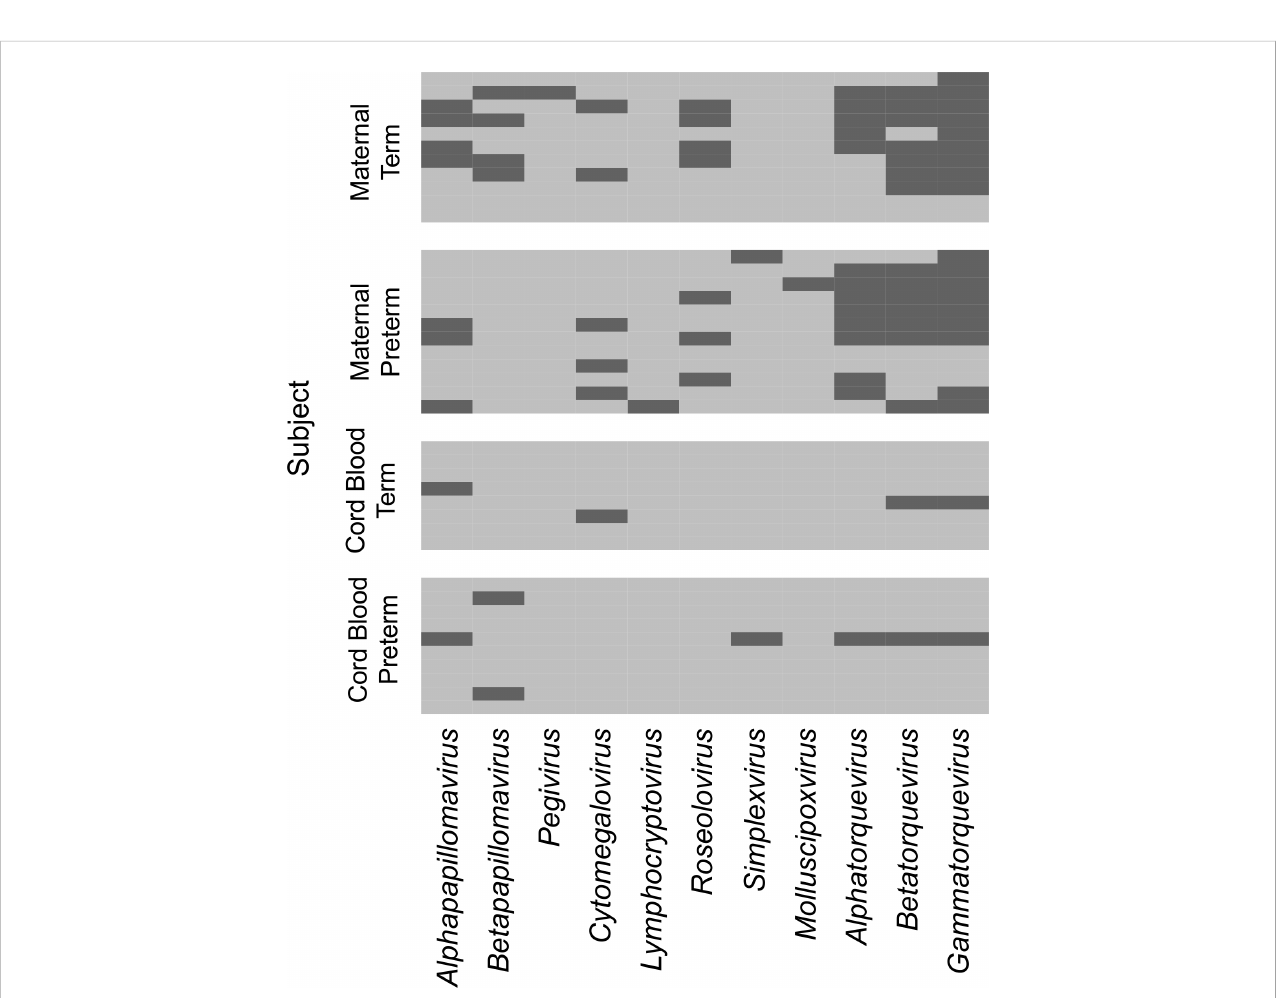
FIGURE 1 Viral genera detected in maternal and cord plasma by metagenomic sequencing. Each row represents data from a maternal subject (top) or cord plasma sample (bottom). The viral genera detected are indicated in the columns. A dark bar indicates the virus was detected in that